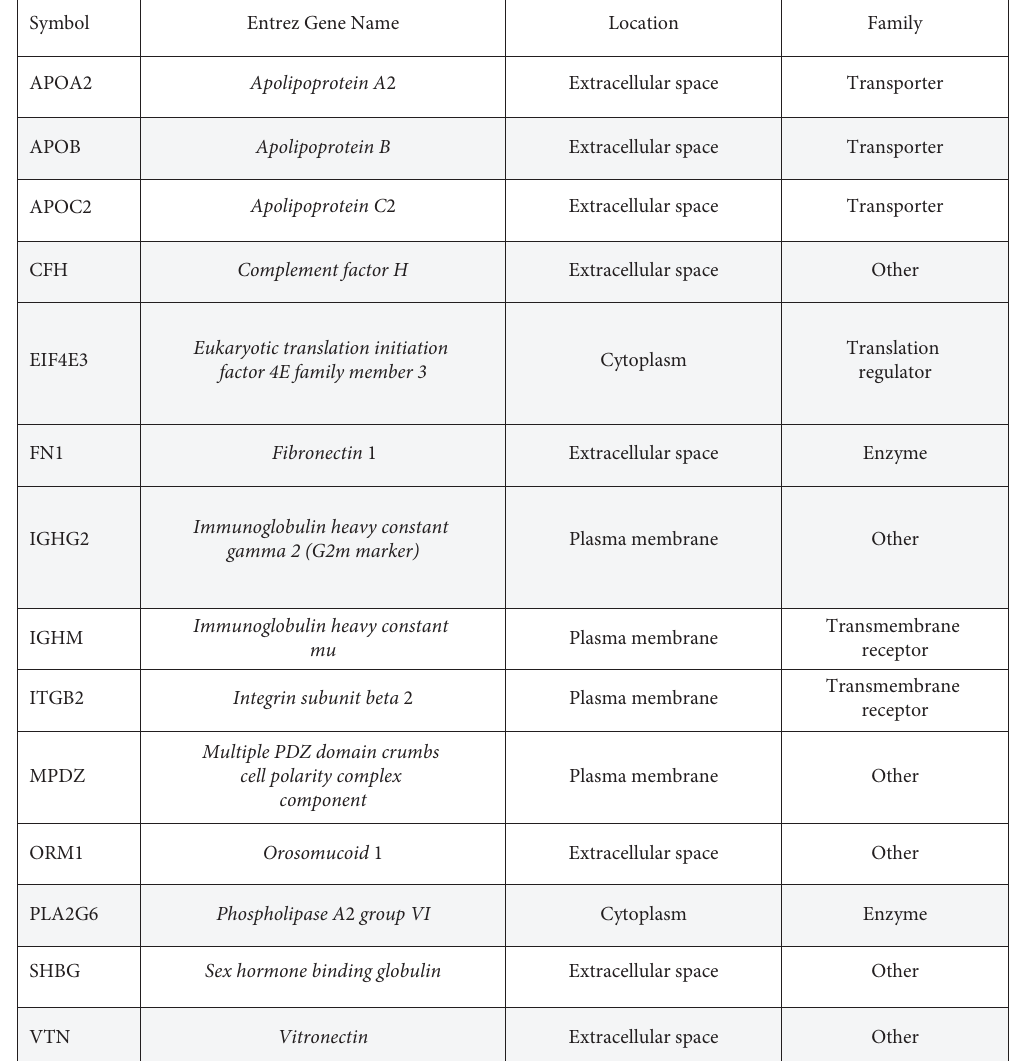
Grey flling indicates PPs upregulated in